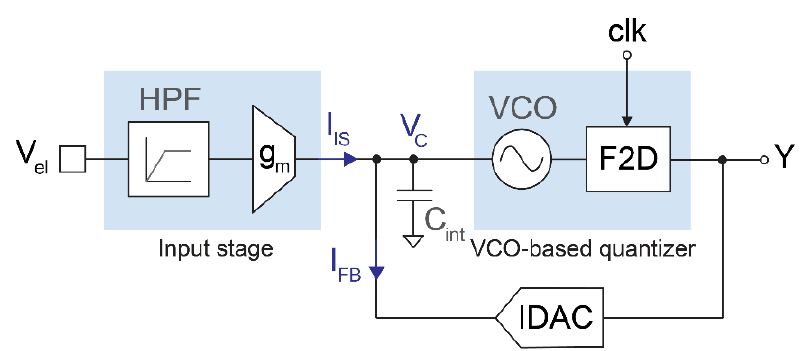
Figure 1. Simplified block diagram of the proposed opamp-less, second-order ∆Σ modulator with VCO-based quantizer.